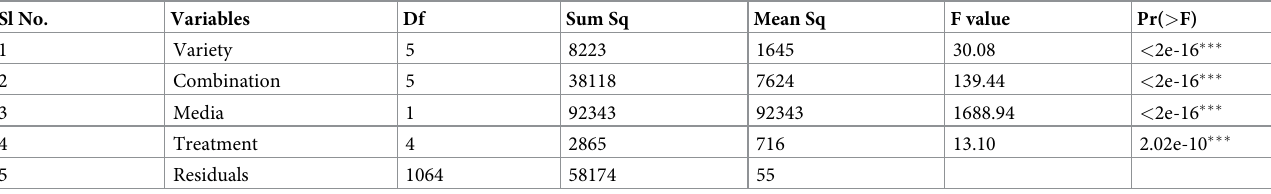
Table 8. ANOVA results for effects of various basal media and pre-incubation conditions on green shoot regeneration. Sl No.